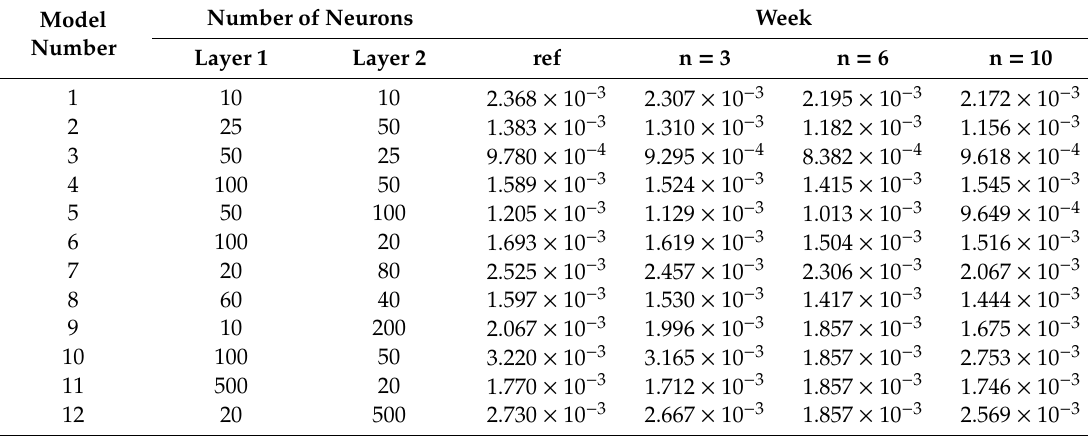
Table 5. MSE values for wavelet-based filtration of CO 2 signals